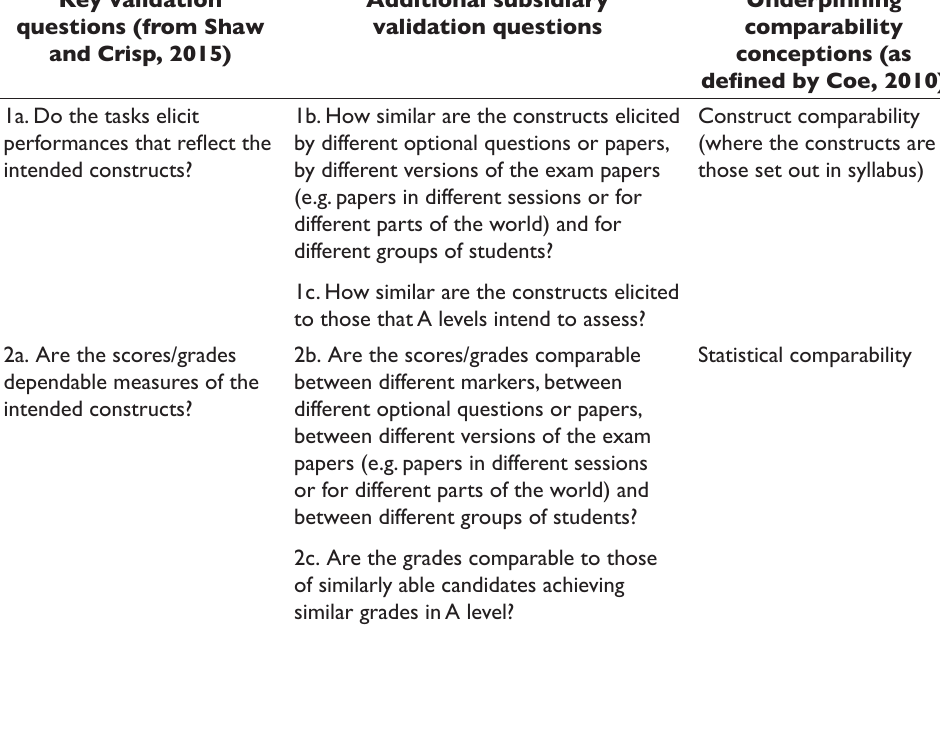
Table 1: Validation questions for a hypothetical level 3 qualification claimed to be comparable to A